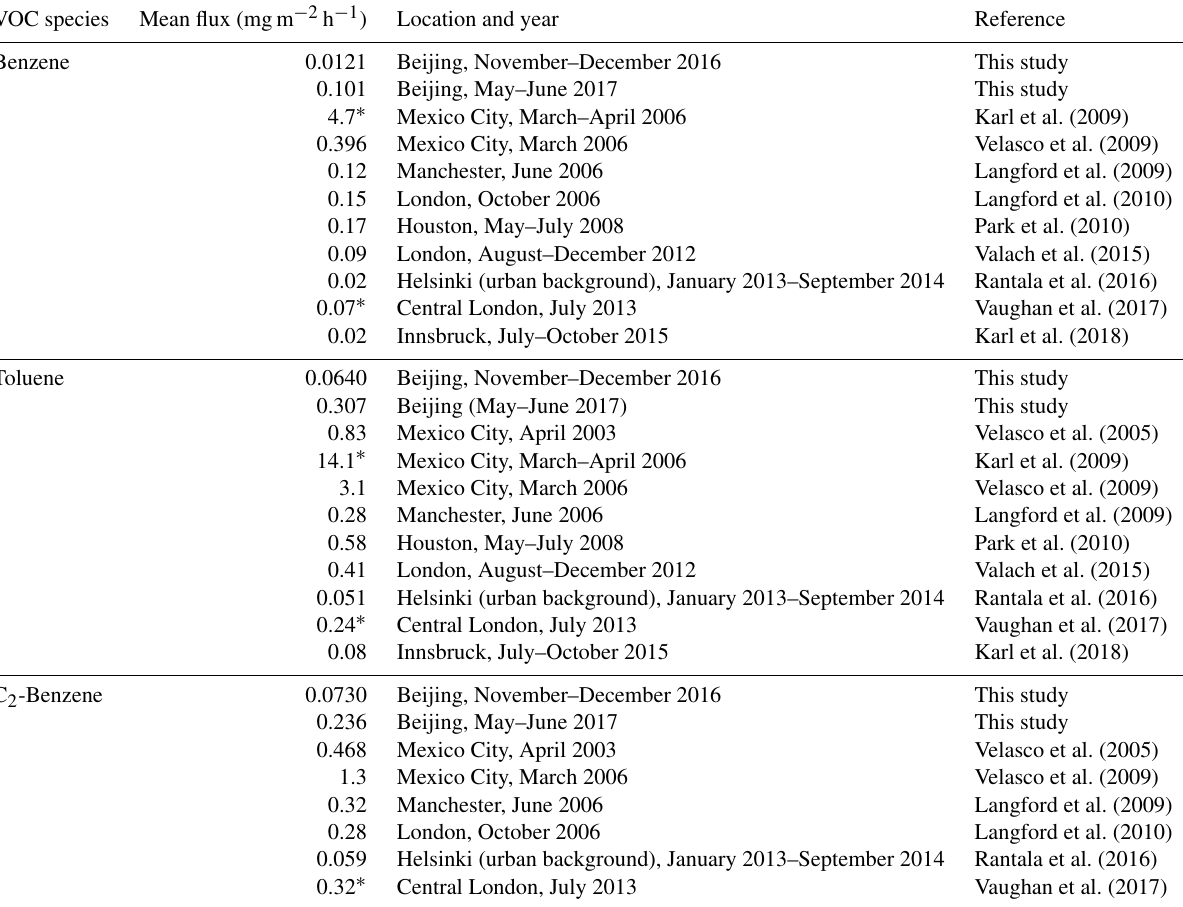
Table 3. Summary of mean VOC fluxes measured in various urban or semi-urban locations. VOC